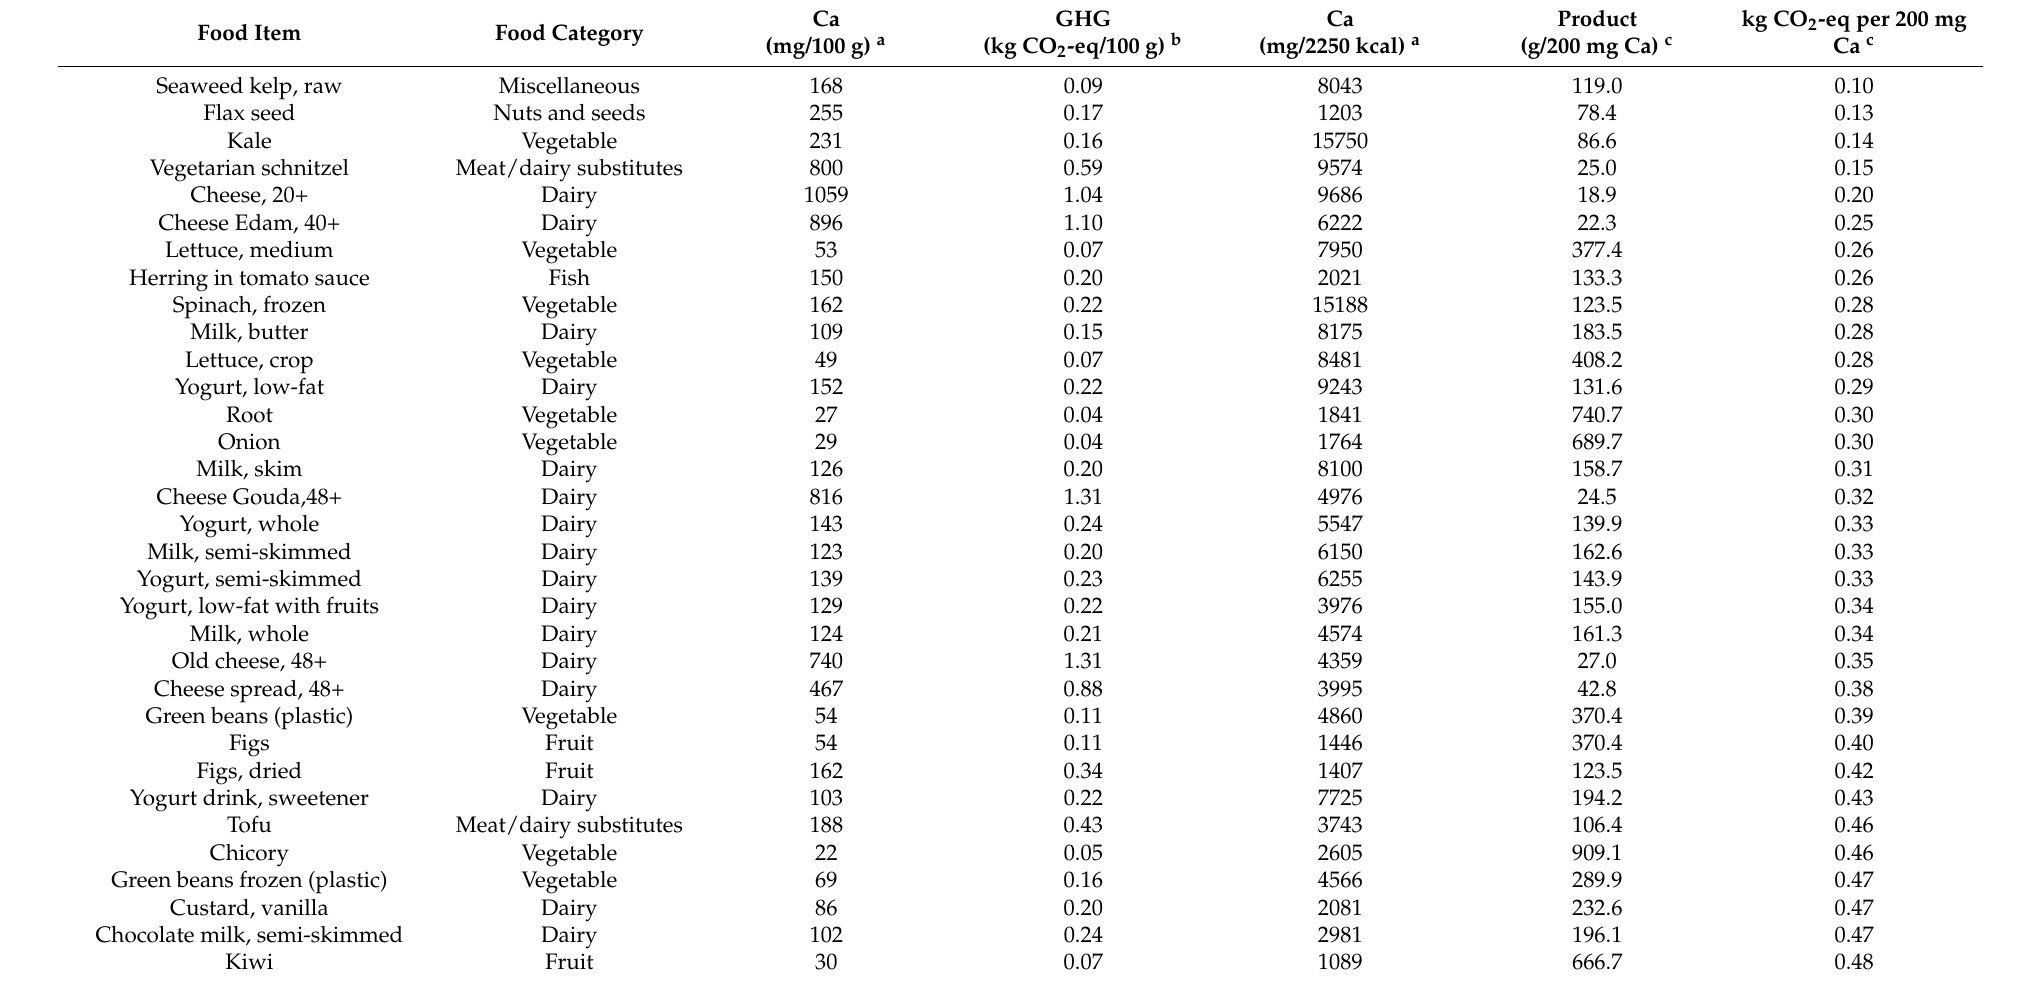
Table 9. Calcium content (in mg/100 g product and mg/2250 kcal), greenhouse gas emissions (GHG; in kg CO 2 equivalents per 100 g product and per 200 mg calcium) and product quantity required to obtain 200 mg calcium for selected Dutch food items. Only food items containing at least 1000 mg calcium per 2250 kcal are